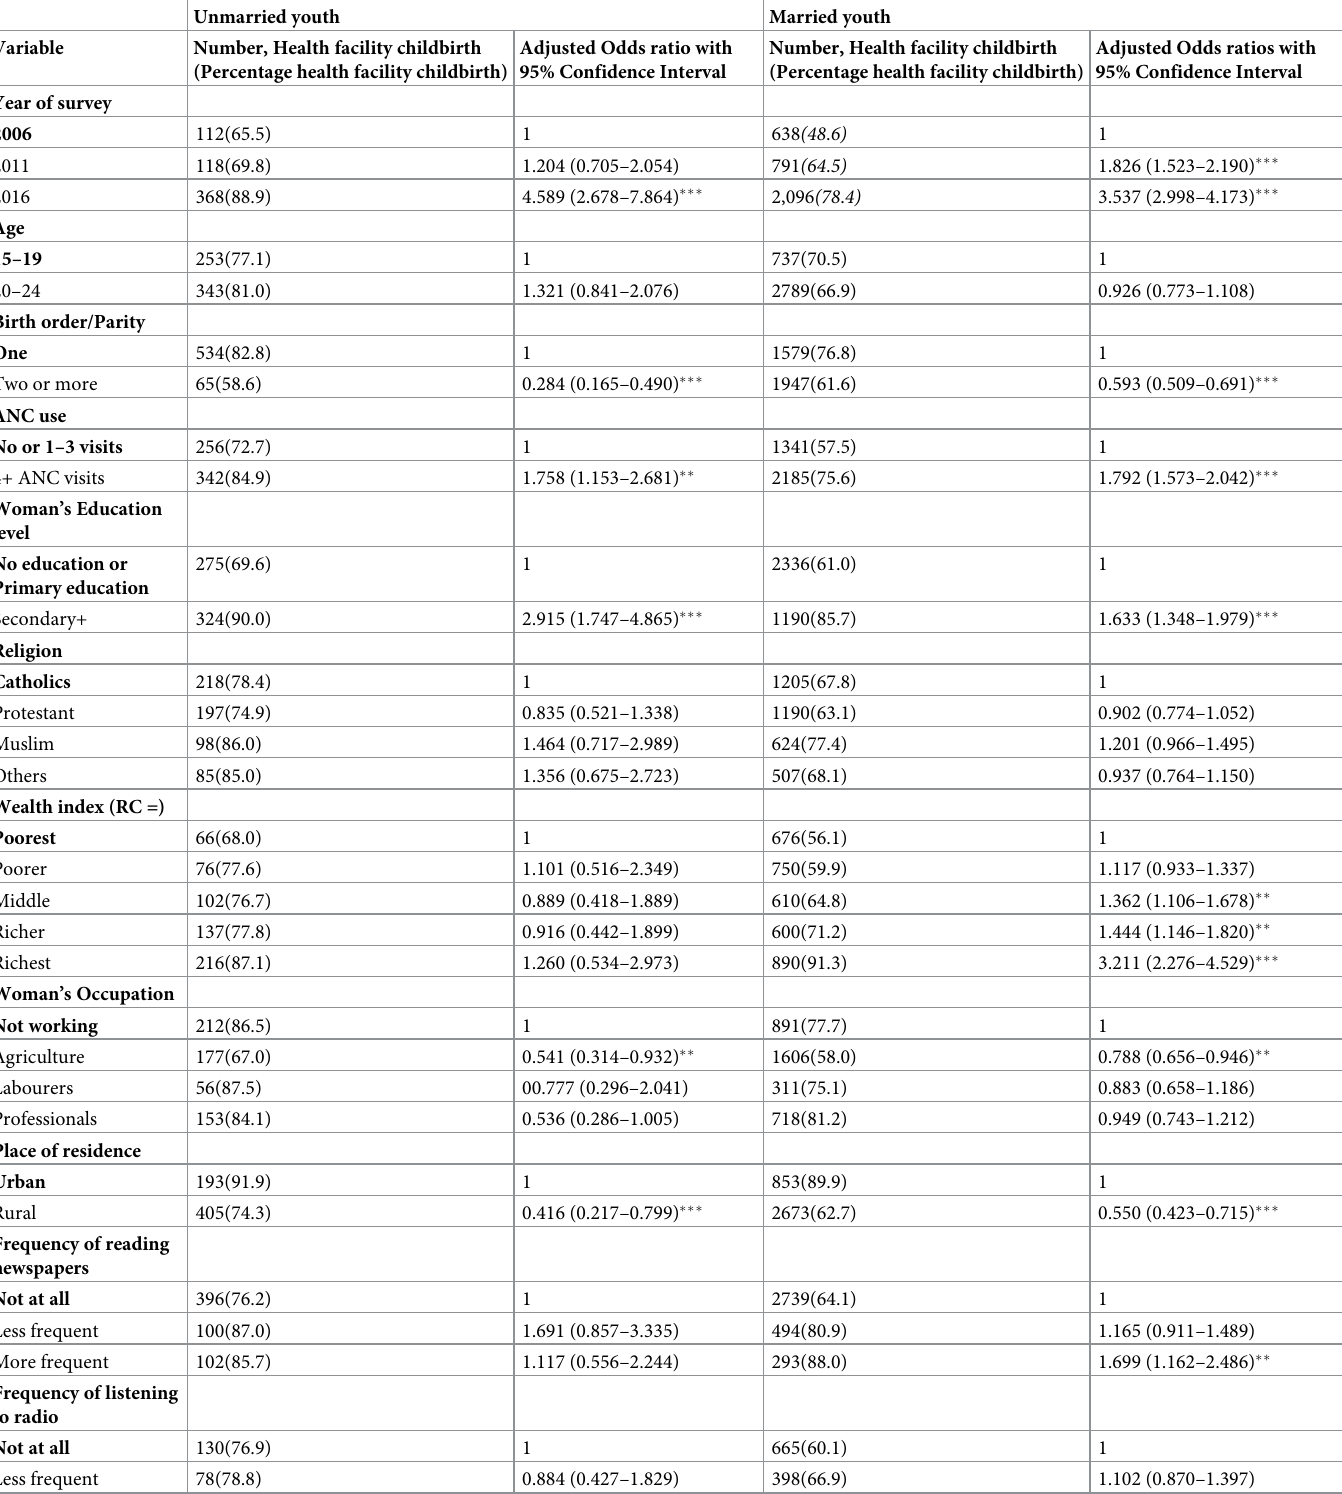
Table 3. Multivariable analysis of factors associated with health facility use at childbirth among youth in Uganda. Unmarried youth Married youth